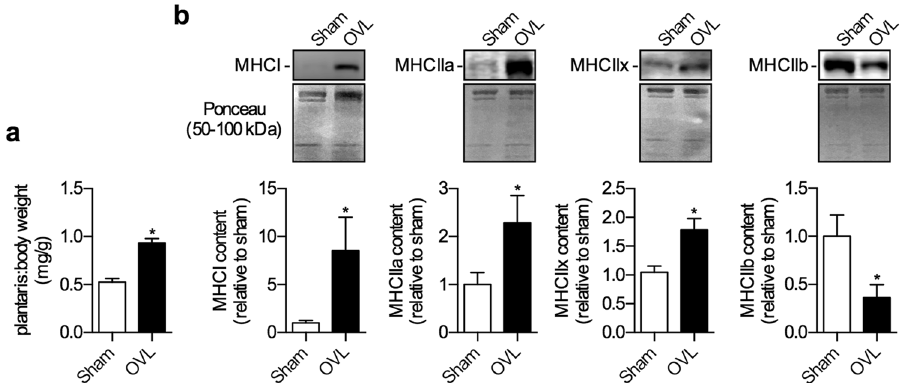
Figure 1. Muscle hypertrophy and a fast-to-slow fiber type shift in the overloaded (OVL) plantaris muscles. ( a ) Plantaris:body weight ratios are significantly higher in the OVL plantaris compared with sham. ( b ) Western blot expression of the MHC isoforms indicates a fast-to-slow fiber type shift with a reduction in IIb and an increase in IIx, IIa, and I. * p ≤ 0.05 using a paired t-test (two-tailed), n = 6 per group. Please refer to Fig. S1 for full length Western